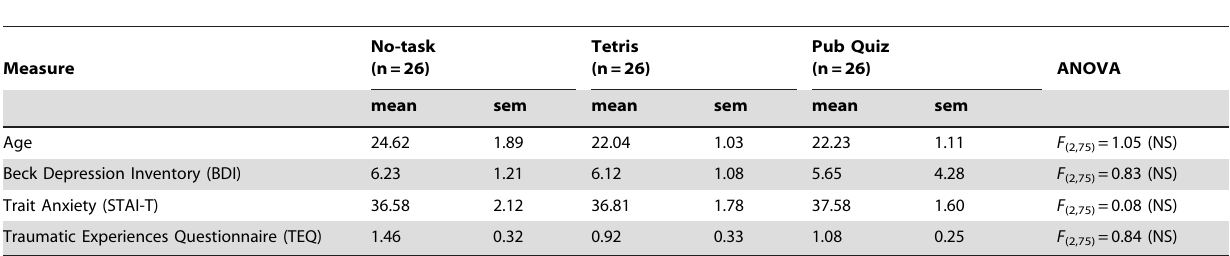
Table 6. Experiment 2 means and statistics for age and baseline assessments indicating experimental conditions were equivalent at